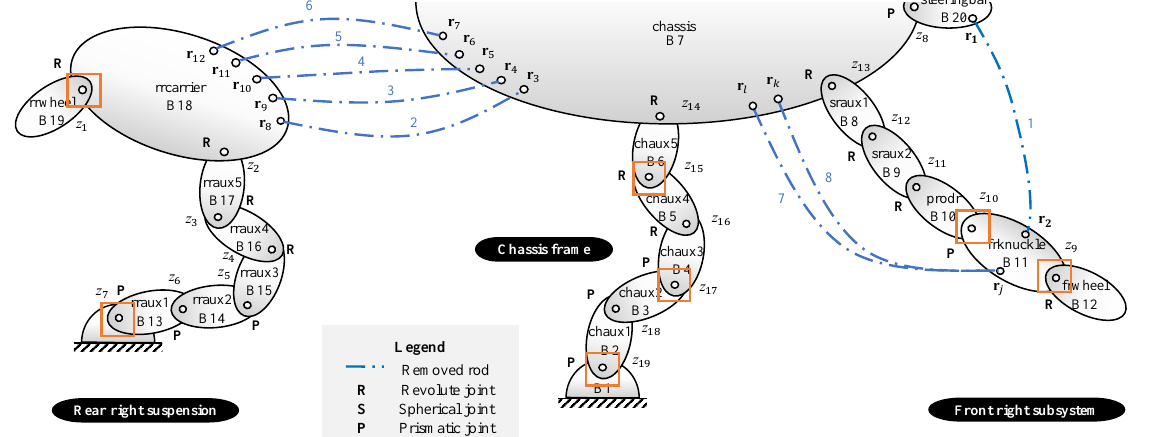
Figure 5. System tree-topology of the 7-DOF vehicle model after removing the suspension lower-arm. When the lower-arm of the front suspension is removed using the fork-arm removal technique, as depicted in Figure 5, the following two loop-closure constrained equations are